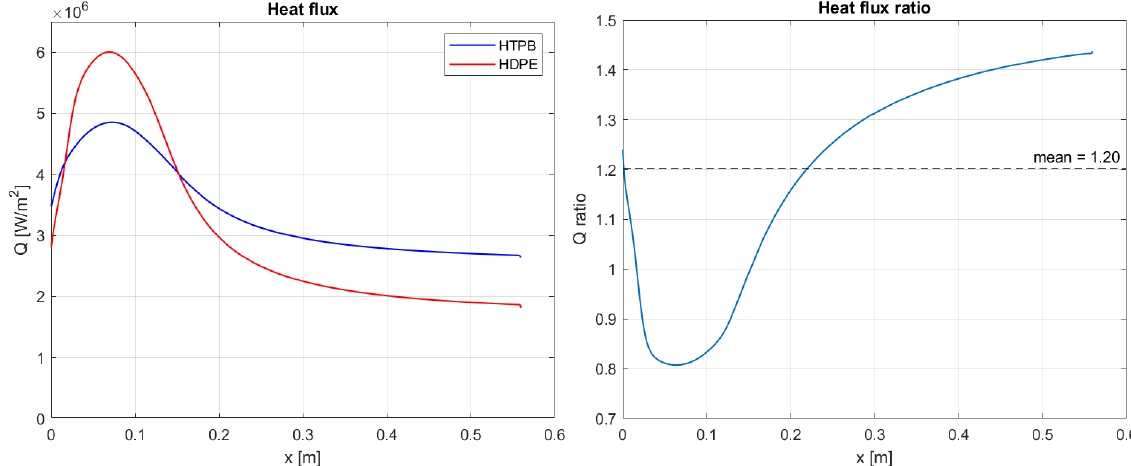
Figure 18. Comparison between HDPE and HTPB heat fluxes obtained from the CFD